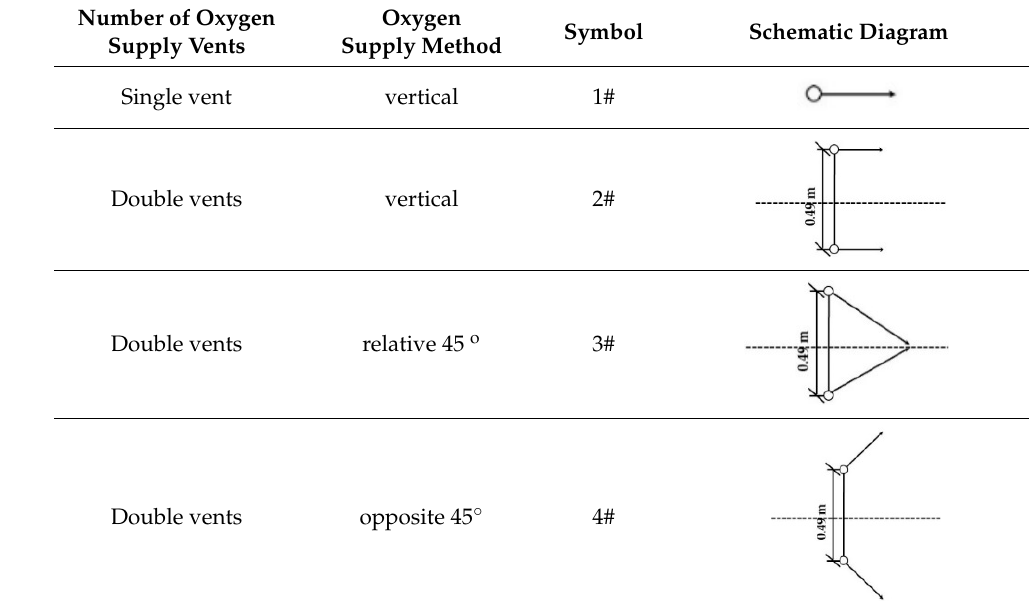
Table 2. Initial conditions of the oxygen supply vent methods.